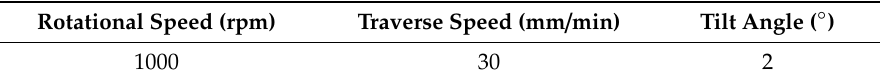
Figure 2. Friction stir welding machine.